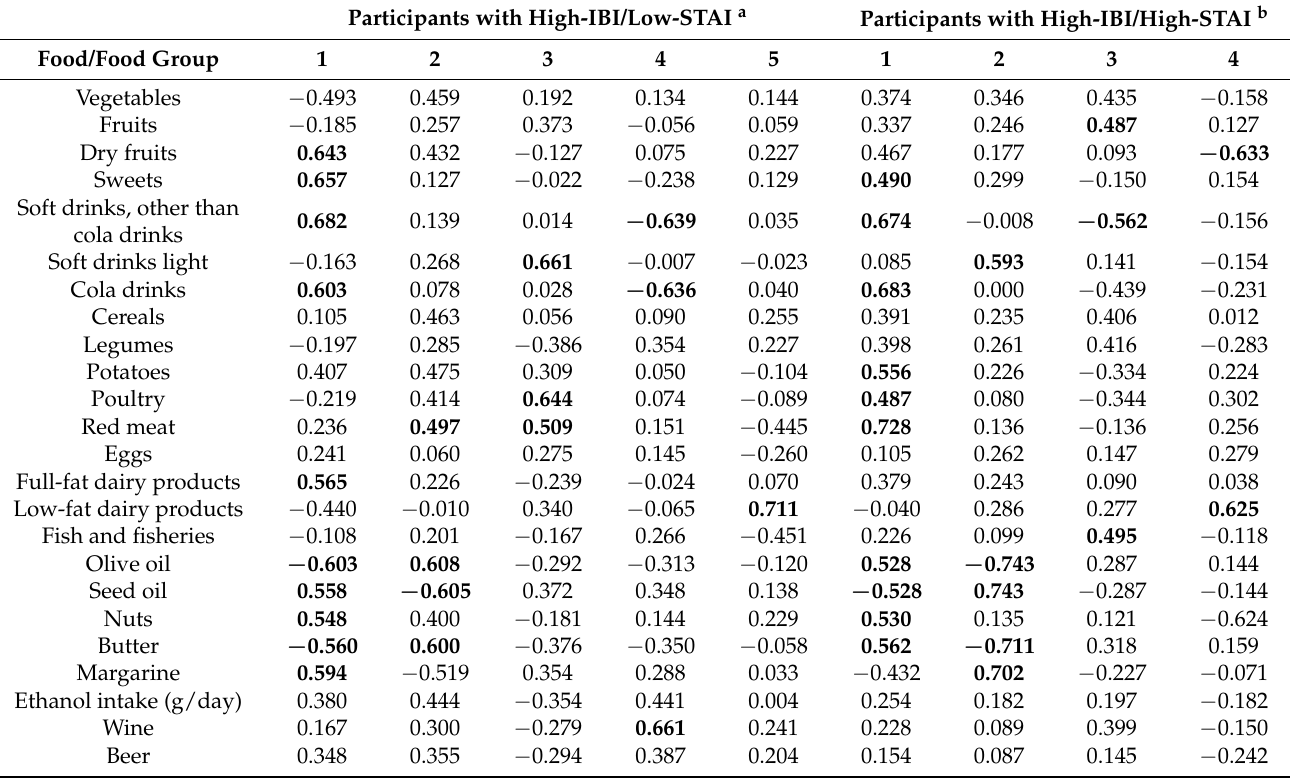
Table 3. Factor coefficients loadings regarding foods or food groups consumed by Greek ATTICA study participants with a high IBI score ( ≥ 52), who also had anxiety symptoms (i.e., STAI > 40) ( n = 853) at baseline. Participants with High-IBI/Low-STAI a Participants with High-IBI/High-STAI